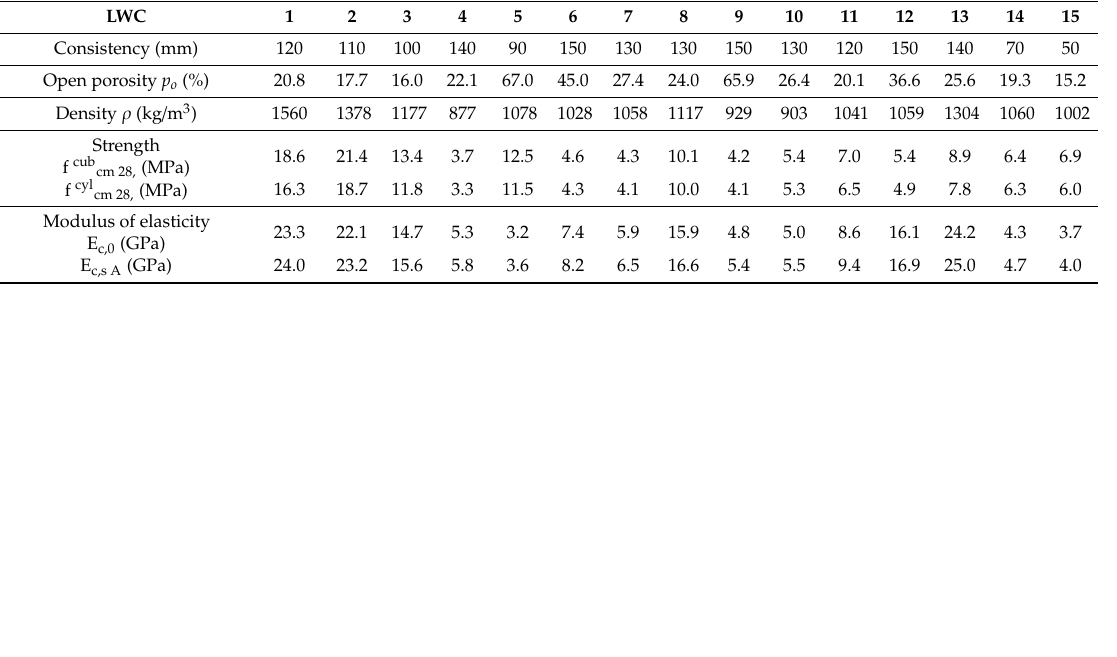
Table 7. Laboratory tests results for LWCs 1–15.